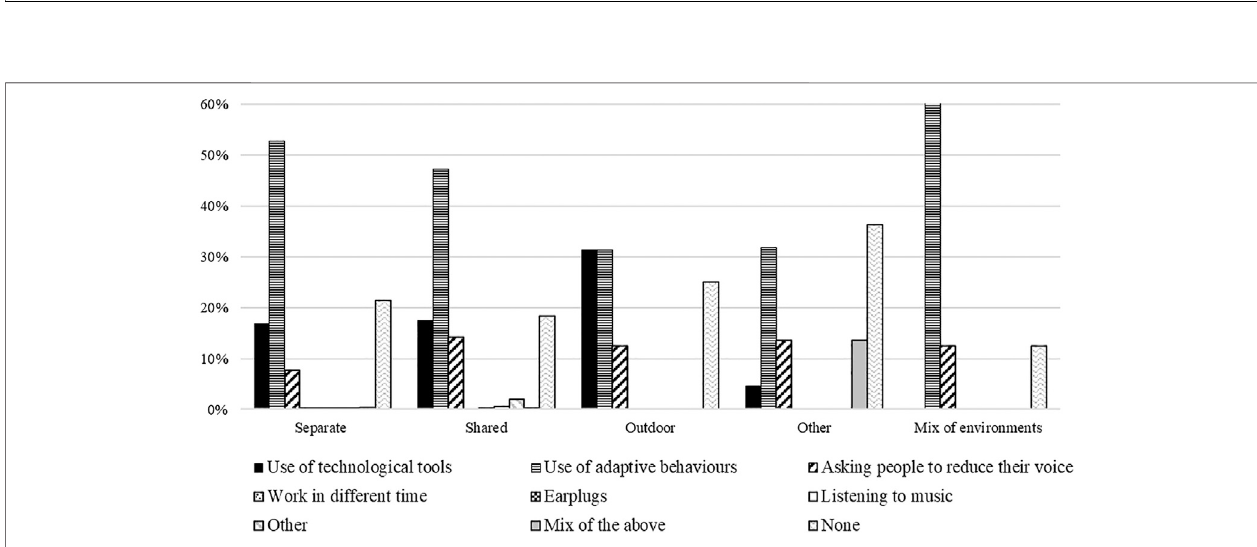
FIGURE 4 | Percentages of the subjective ratings of the effects of noise in the different remote working environments on occupants ’ behavior (i.e., strategies to cope with noise).